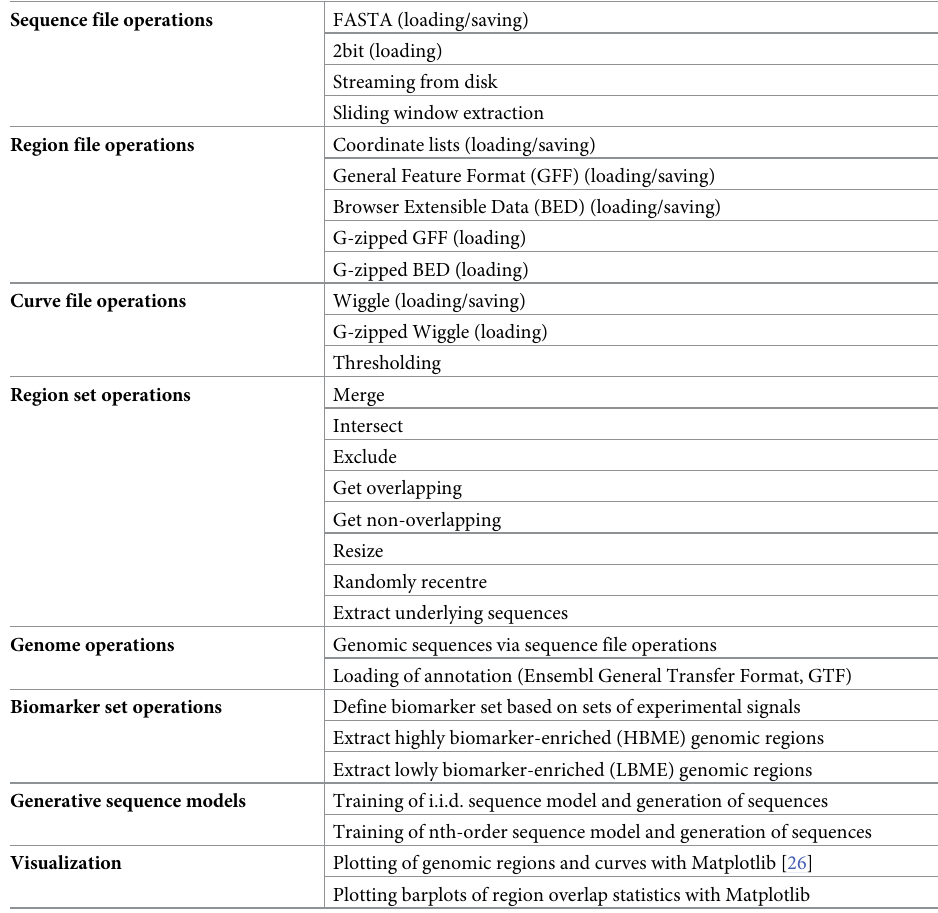
Table 1. Core data preparation